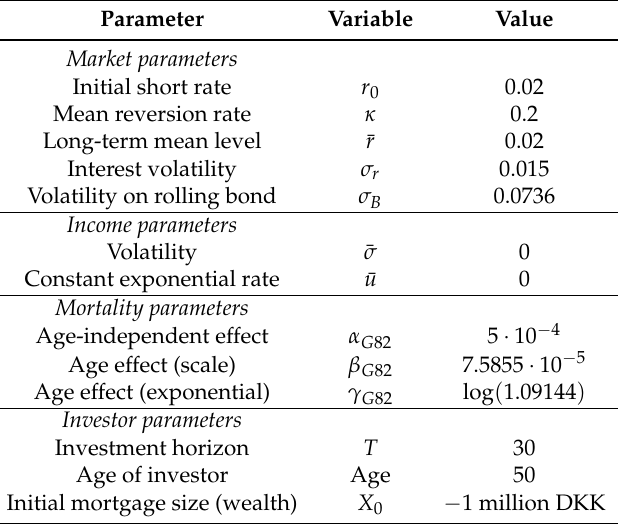
Table 1. Fixed parameters used in all of the numerical examples. The market parameters are consistent with Kraft and Munk [4].